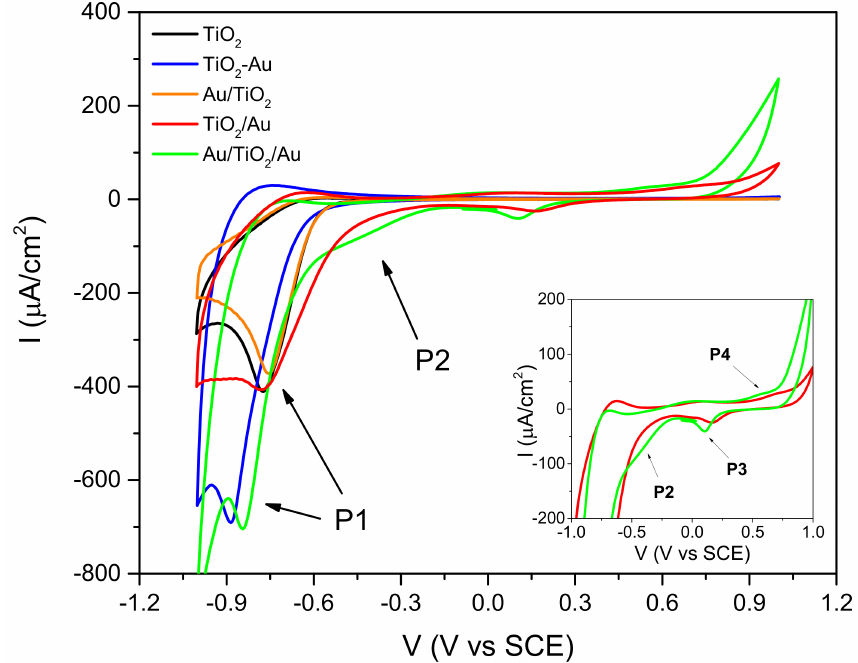
Figure 6. Cyclic Voltammetries (CV) in supporting electrolyte in dark conditions; the typical peaks of Ti(III)/T(IV) (P1), and of Au redox behavior (P3 and P4) are evidenced in the inset, as well as the wave related to O 2 reduction